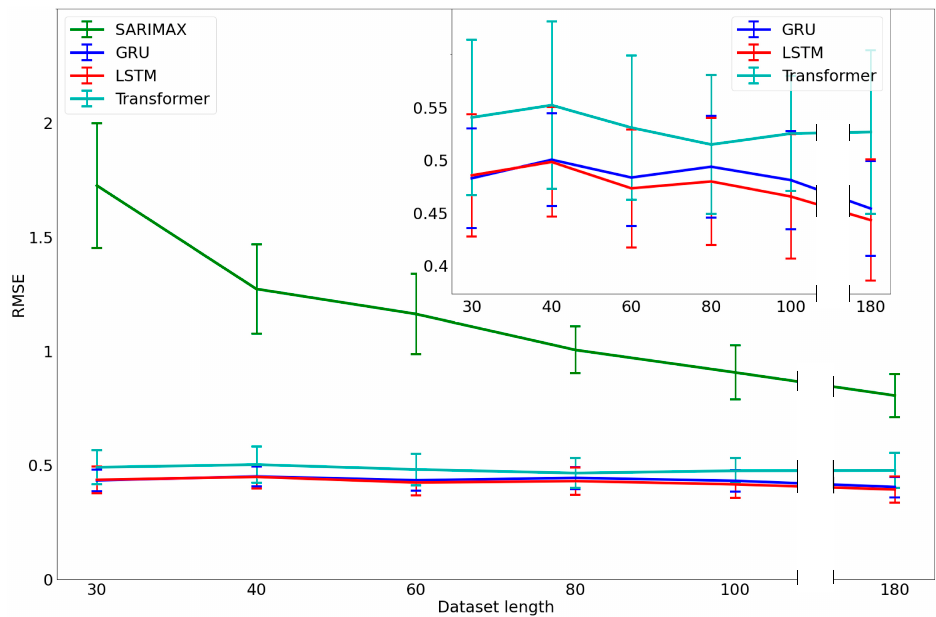
Figure 8. Mean RMSEs and deviation standards for each model for different dataset lengths, with a 7-day forecasting. In the inset at right, an enlargement of the deep-learning RMSEs is reported.